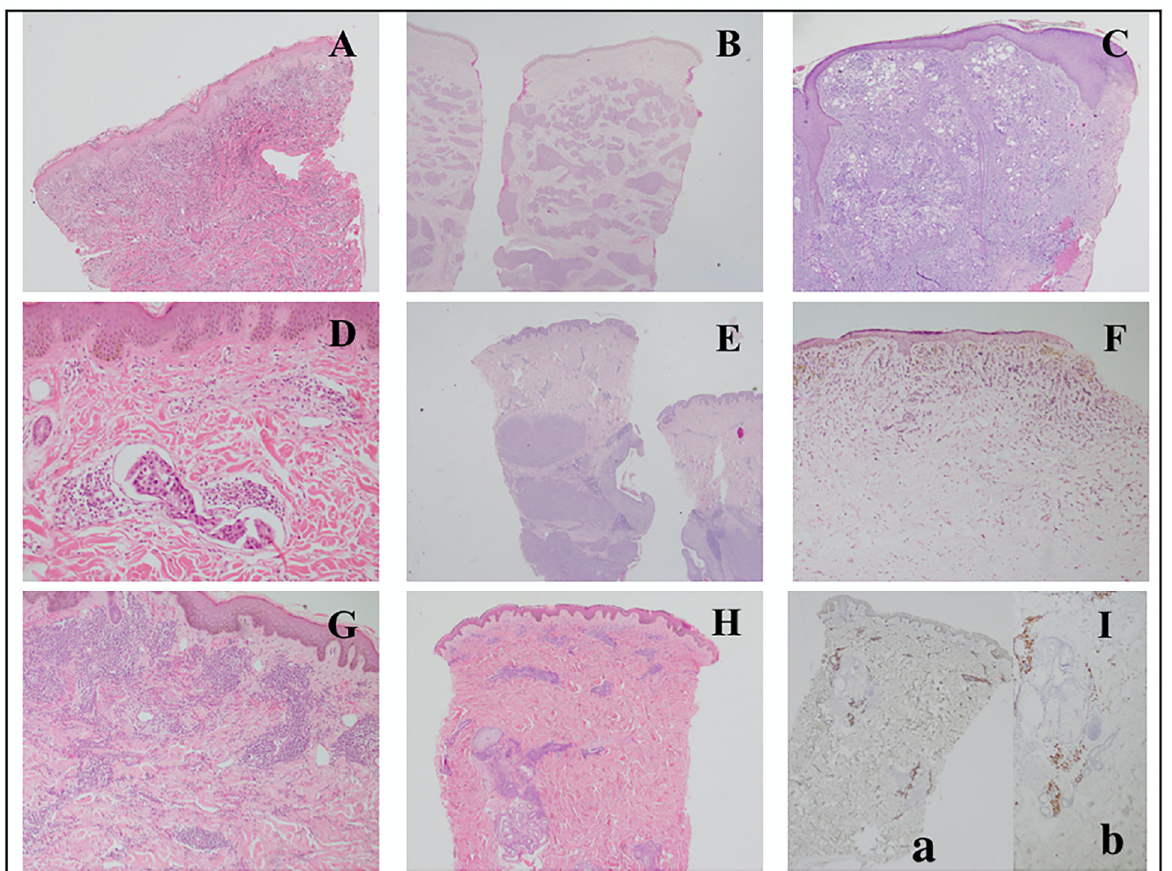
Figure 4. Representative photos of histologic patterns seen in this study. ( A ) Infiltrative pattern: Tumor cells insinuating in between collagen bundles in a breast cancer patient (4 × ); ( B ) Nodular pattern: tumor cells in nodules scattered throughout the dermis in an esophageal cancer patient (2 × ); ( C ) diffuse pattern: diffuse proliferation of atypical cells in a patient with unknown primary malig- nancy (4 × ); ( D ) intravascular pattern: atypical cells seen within a blood vessel with thin endothelial lining (20 × ). Patient has breast cancer; ( E ) bottom-heavy pattern: tumor cells that are nodules seen in a breast cancer patient (4 × ); ( F ) top-heavy pattern: strands of atypical cells seen mostly in the upper dermis (20 × ). Patient has breast cancer; ( G ) nodular and infiltrative pattern: tumor cells that are nodules and in strands seen in a leukemia cancer patient (20 × ); ( H ) superficial and deep perivascular pattern: mild superficial and deep perivascular infiltrates that are positive for myeloperoxidase stain (MPO) in a patient with leukemia (2 × ) ( I ) ( a ) MPO stain performed highlighting the atypical cells in case 101 (2 × ) ( b ) atypical cells also seen around periadnexal structures (10 × ). Table 3. General histologic patterns seen in the study.